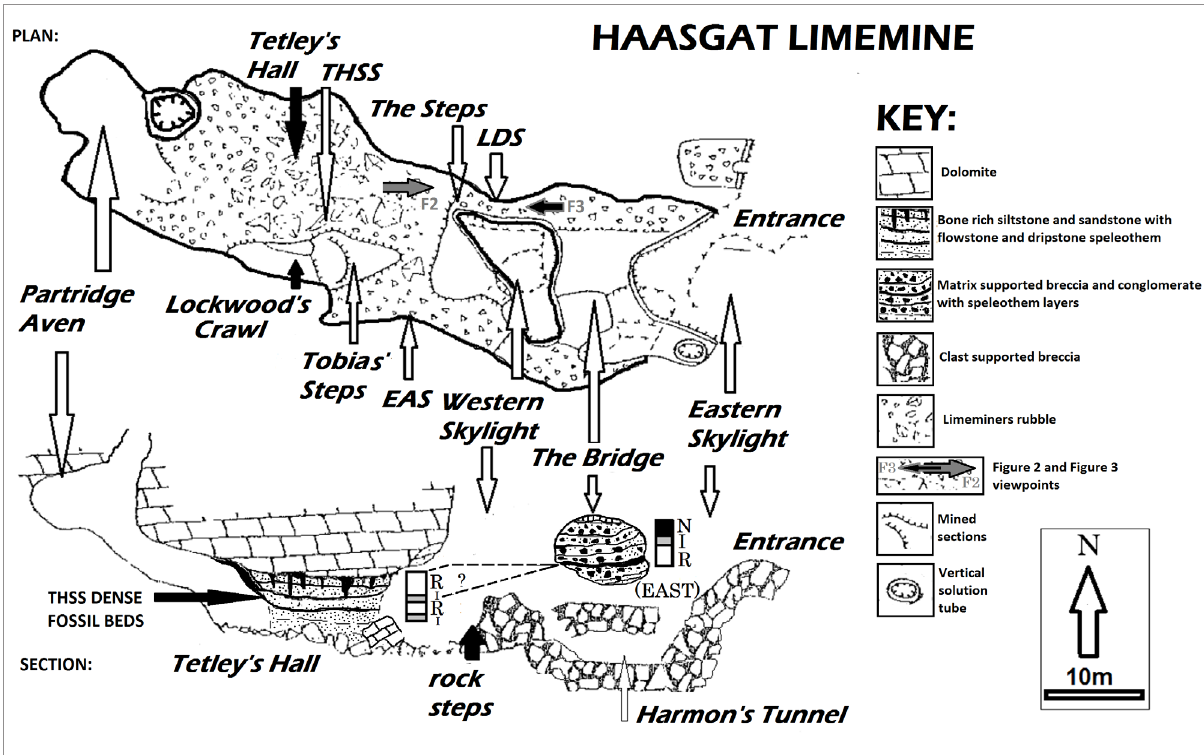
A plan view and a cross-sectional view of the Haasgat Limemine (redrawn using data of Keyser and Martini 22 ) showing the major features and stratigraphy described in the text and composite palaeomagnetic polarity of the western and eastern sections. The location of the main in-situ bone bed is shown, as are the perspectives of Figures 2 and